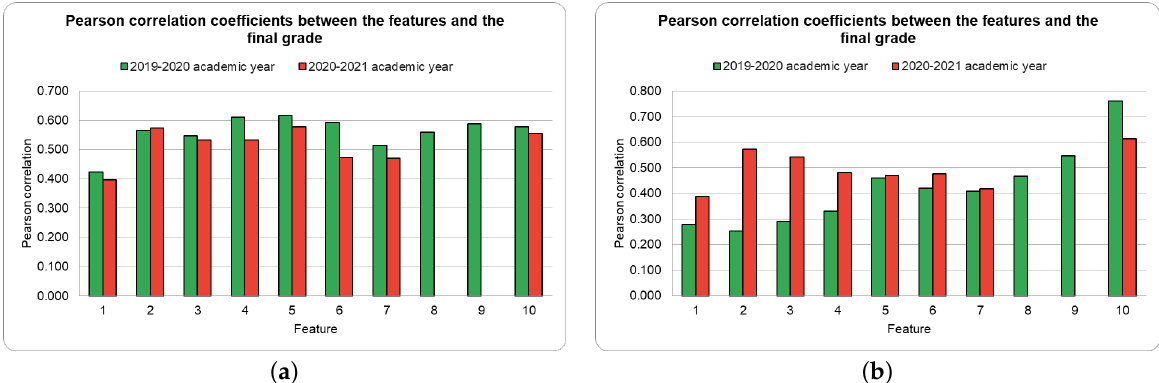
Figure 2. Correlations between the features and the final grade for the first case study ( a ) and second case study ( b